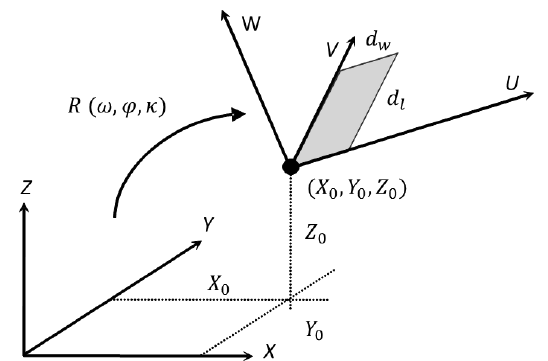
Figure 9. Definition of the object and model space coordinate systems, and the pose and shape parameters of a rectangular model (after Kwak et al.